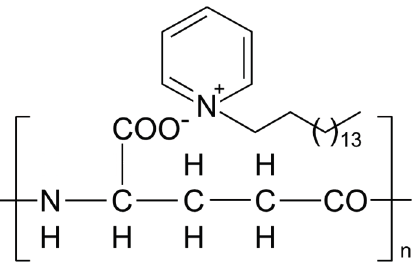
Figure 1. Chemical Structure of poly- γ -glutamate ion-complexes (PGAIC) consisted of PGA and hexadecylpyridinium (HDP + ). As the molecular weight of archaeal L -PGA is on average over 800,000, its number-average degree of polymerization, i.e. , n , is estimated to be